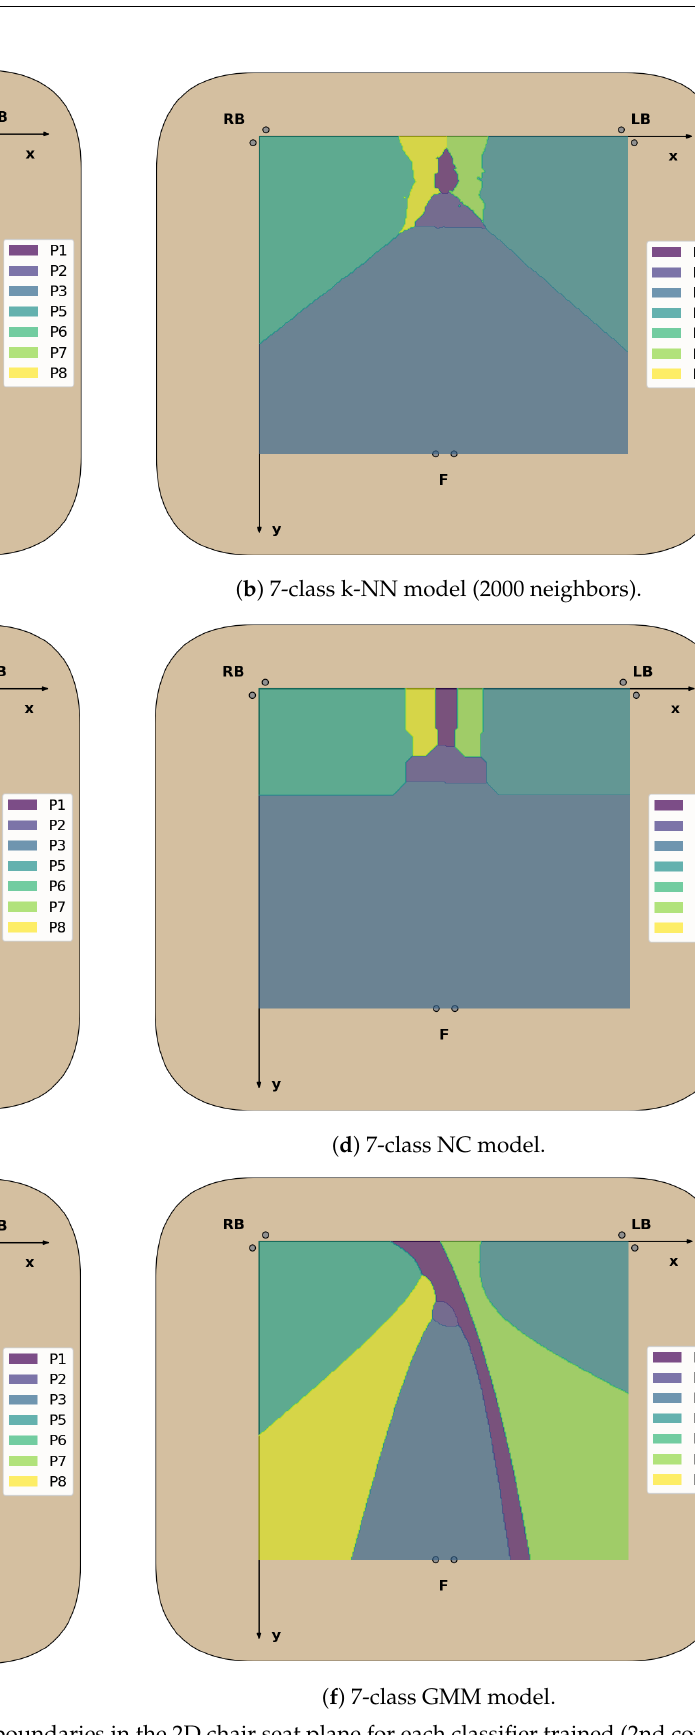
Figure A9. Decision boundaries in the 2D chair seat plane for each classifier trained (2nd